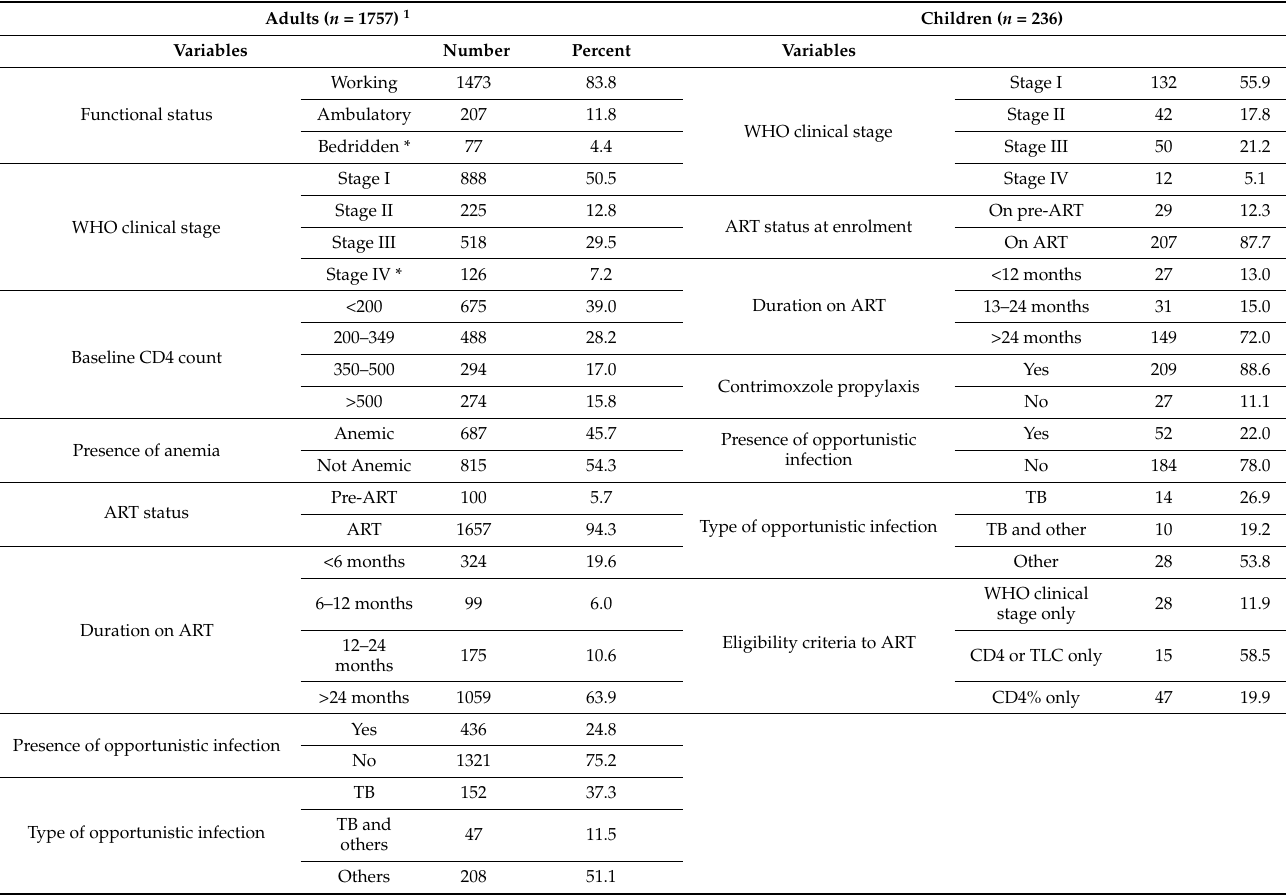
Table 2. Clinical and immunological characteristics of adults and children enrolled in the nutritional